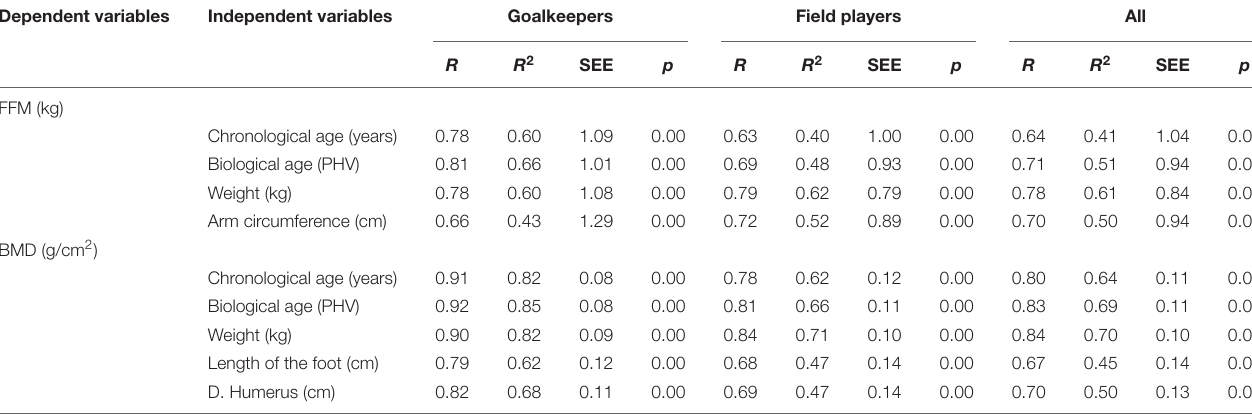
TABLE 2 | Multiple linear regression values of FFM and BMD as dependent variables. Dependent variables Independent variables Goalkeepers